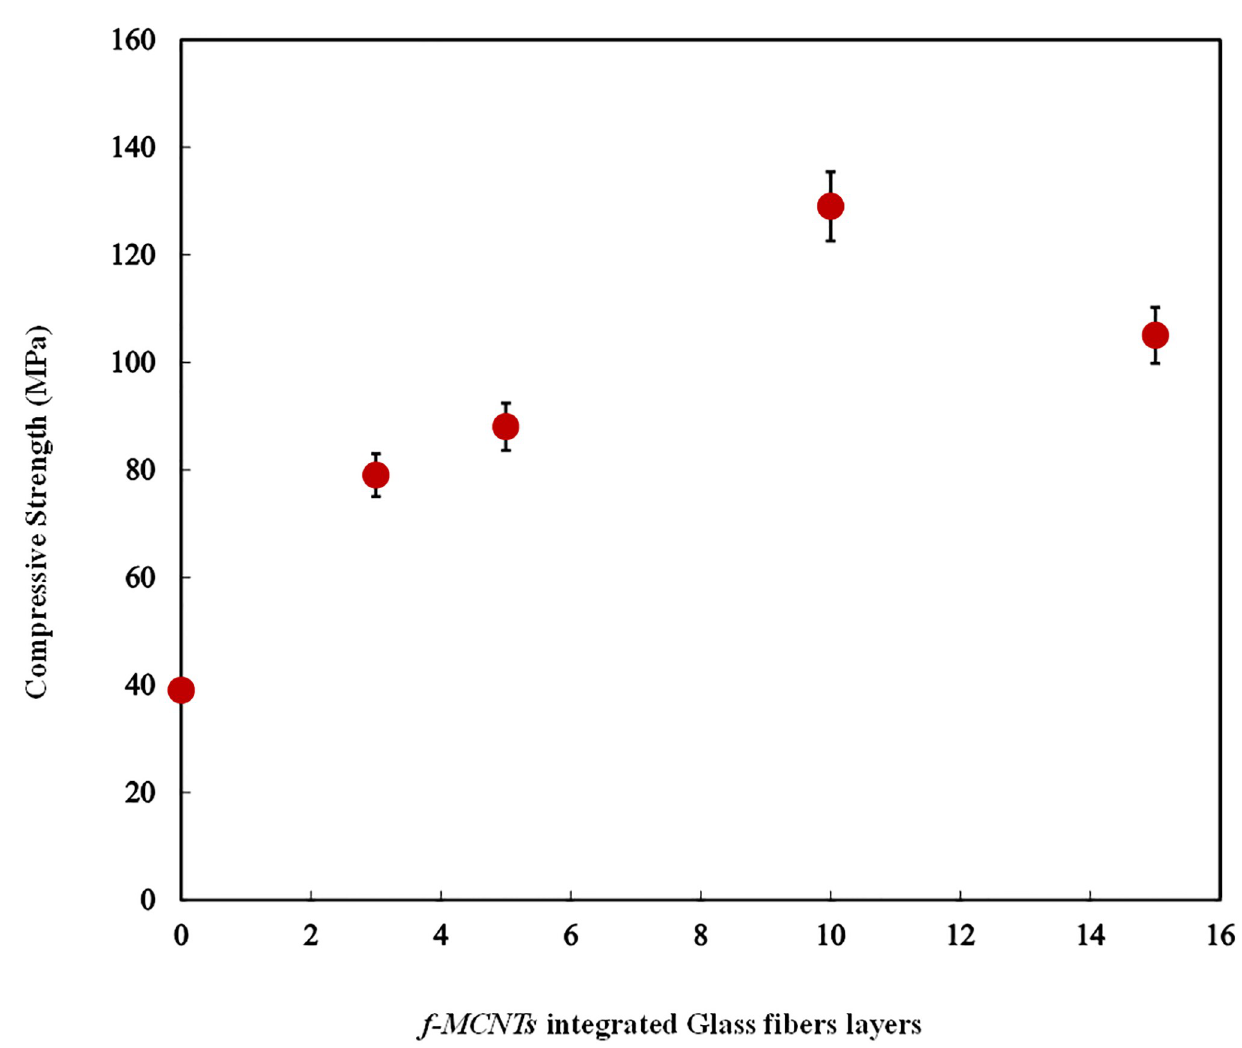
Fig 10. Compressive strength as a function of glass fiber layers modified